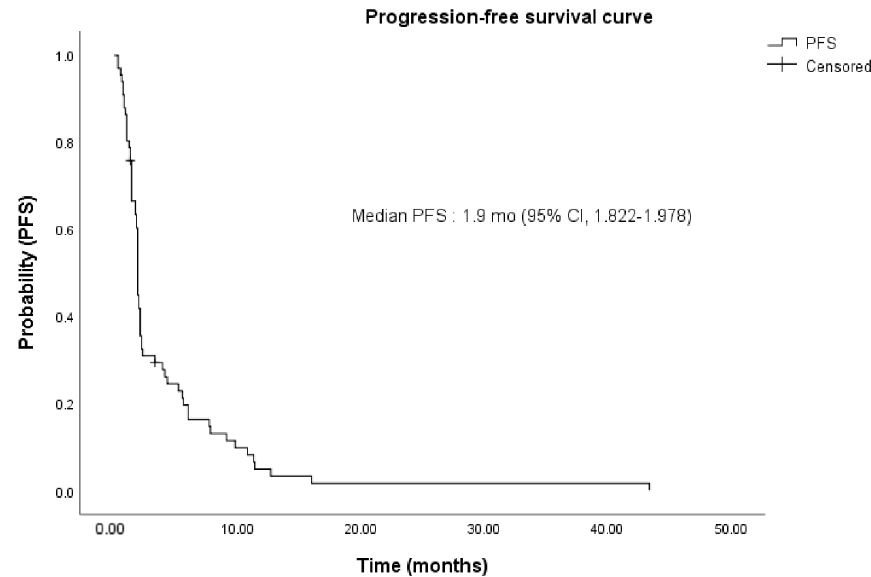
Figure 3. Kaplan–Meier estimates of the progression-free survival (PFS) of the entire study population (n = 80). Median PFS was 1.9 (95% CI, 1.822–1.978) months. PFS, progression-free survival; mo, month; CI, confidence interval.